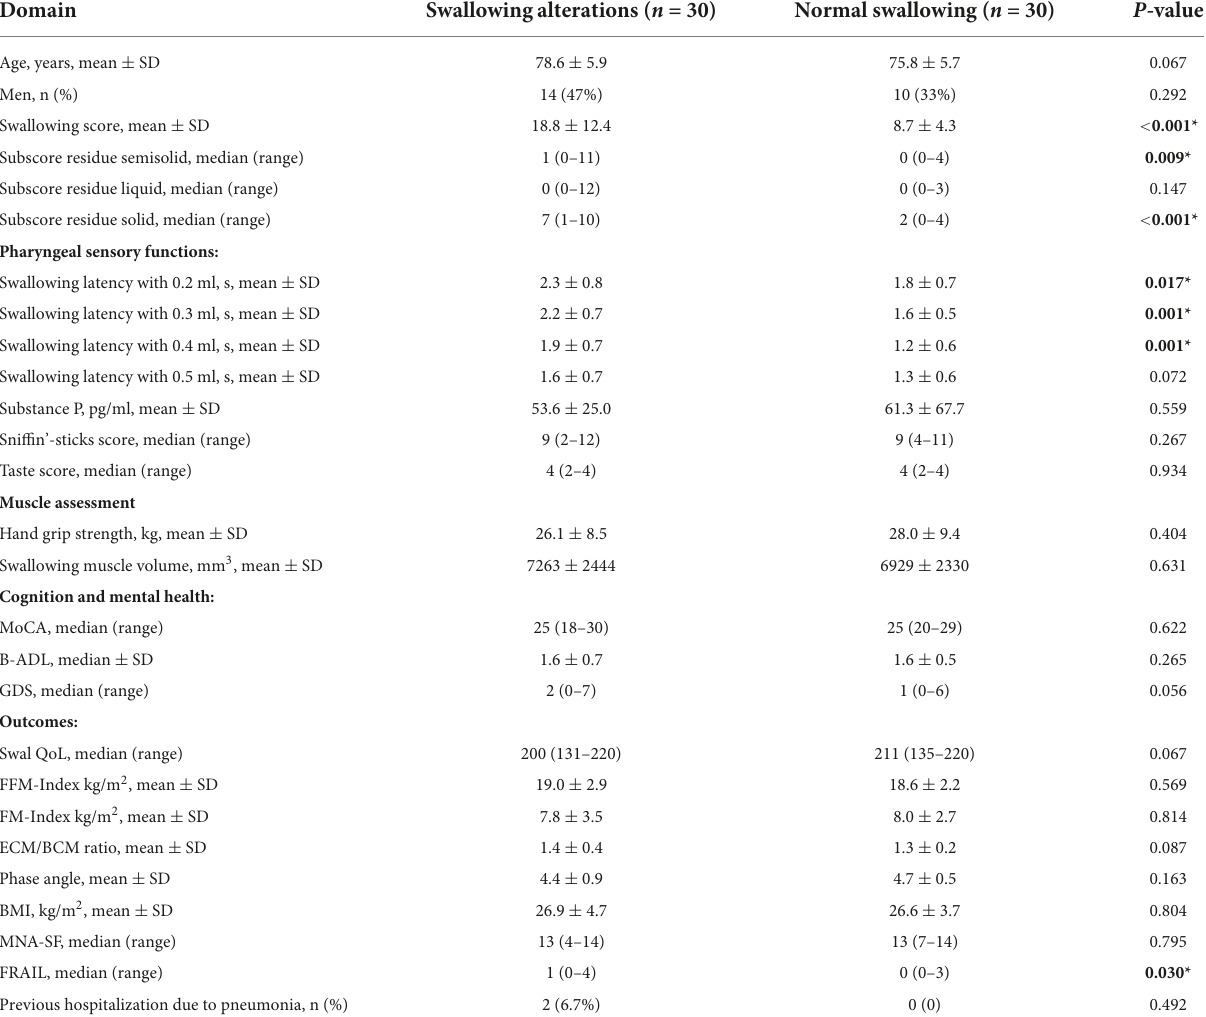
TABLE 1 Clinical comparision of the participants with vs. without swallowing